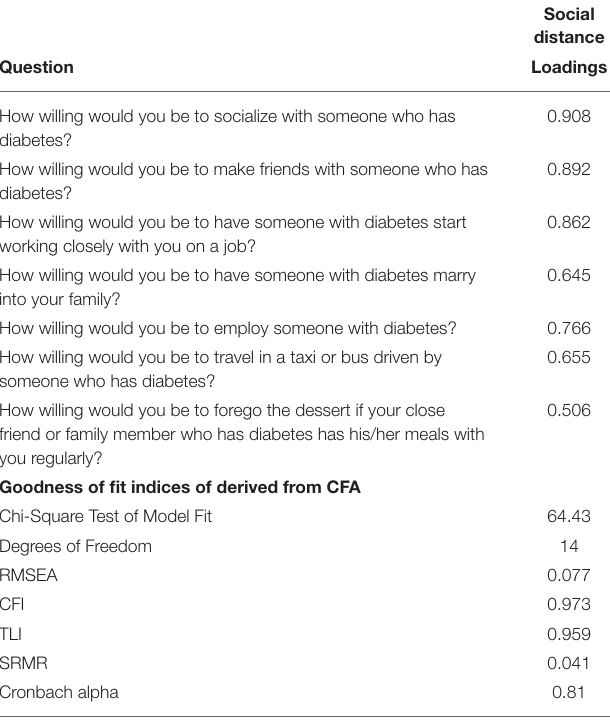
Negative attitudes